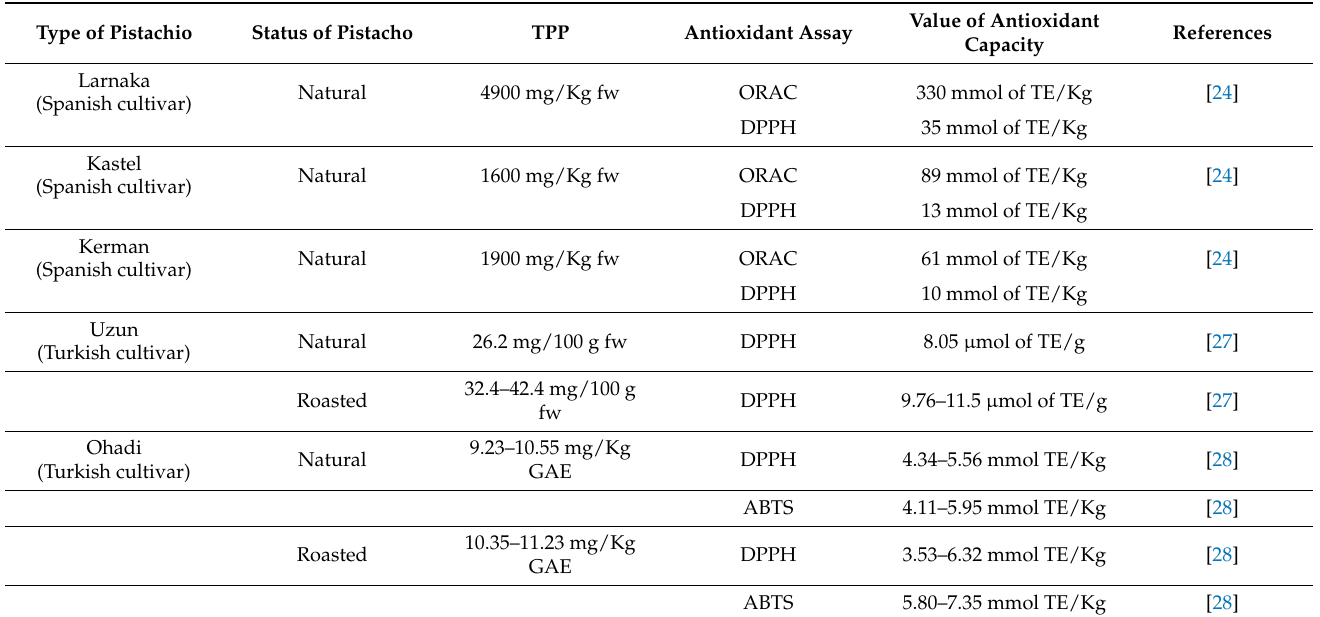
Table 2. Total phenolic content and antioxidant activities of different varieties of